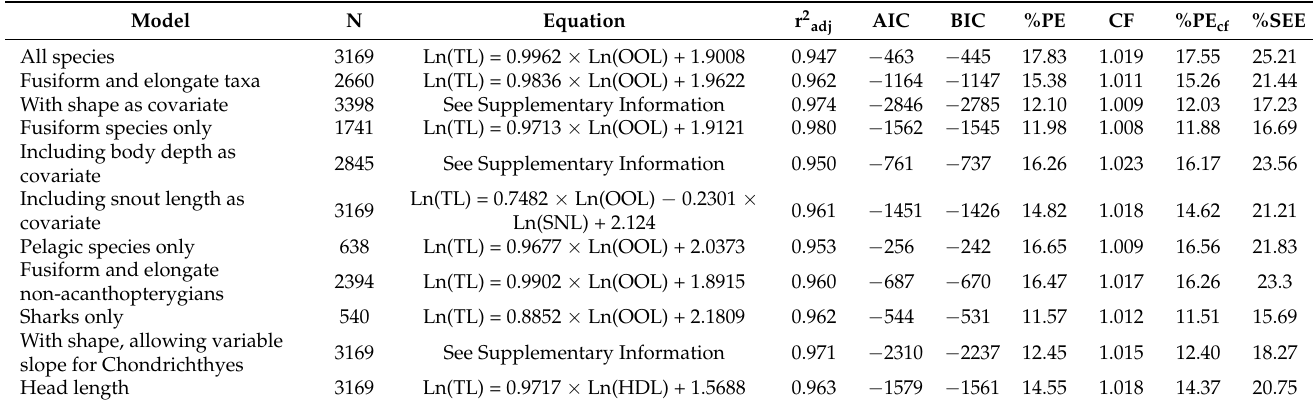
Table 1. Regression equations and support statistics for some of the best-fitting models. All equations reported here are for models using individual specimens, not species averages. Additional statistical information, including models fitted using species averages, can be found in Supplementary File S3. Note more complex multivariate equations are listed in Supplementary File S3 due to space